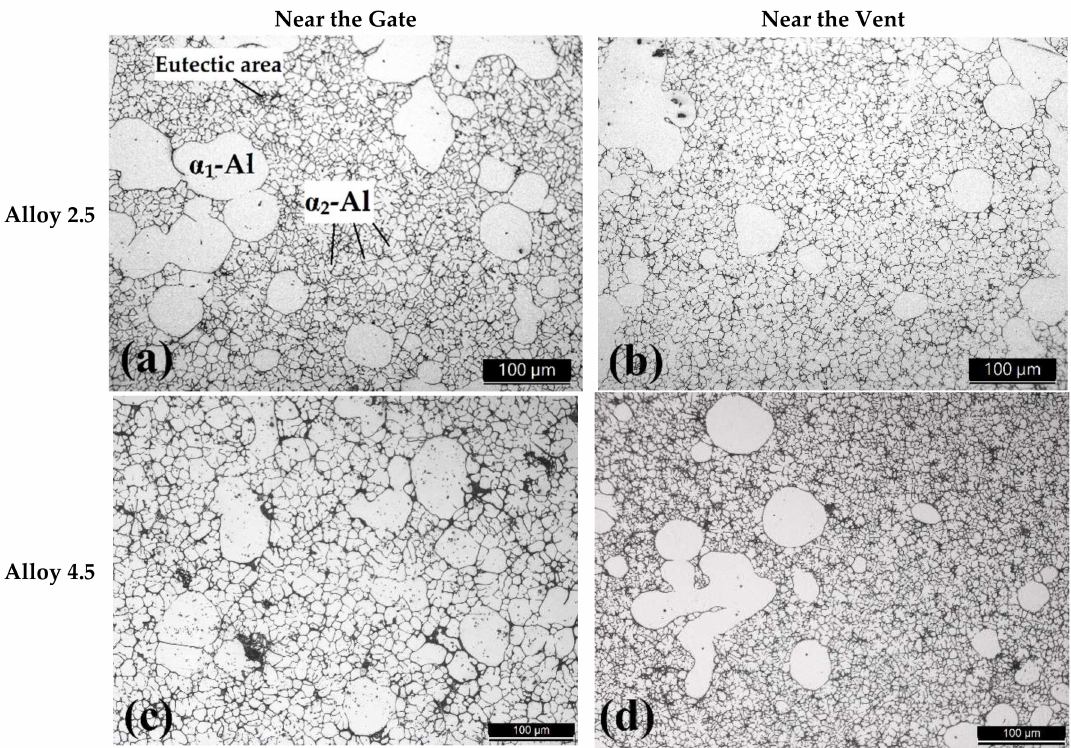
Figure 3. Light optical microscope (LOM) images of sample ( a ) 2.5 RGP; ( b ) 2.5 RVP; ( c ) 4.5 RGP and ( d ) 4.5 RVP.